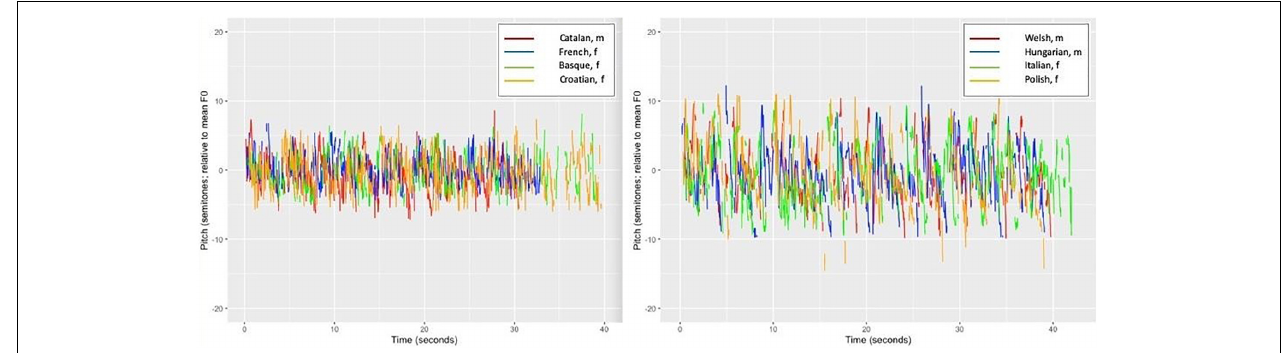
FIGURE 6 | The pitch range (F0 fluctuations) for the four flattest (Catalan, French, Basque, and Croatian) and the four most variable/melodic (Welsh, Hungarian, Italian, and Polish) languages. F0 fluctuations are shown in terms of ± standard deviations of musical